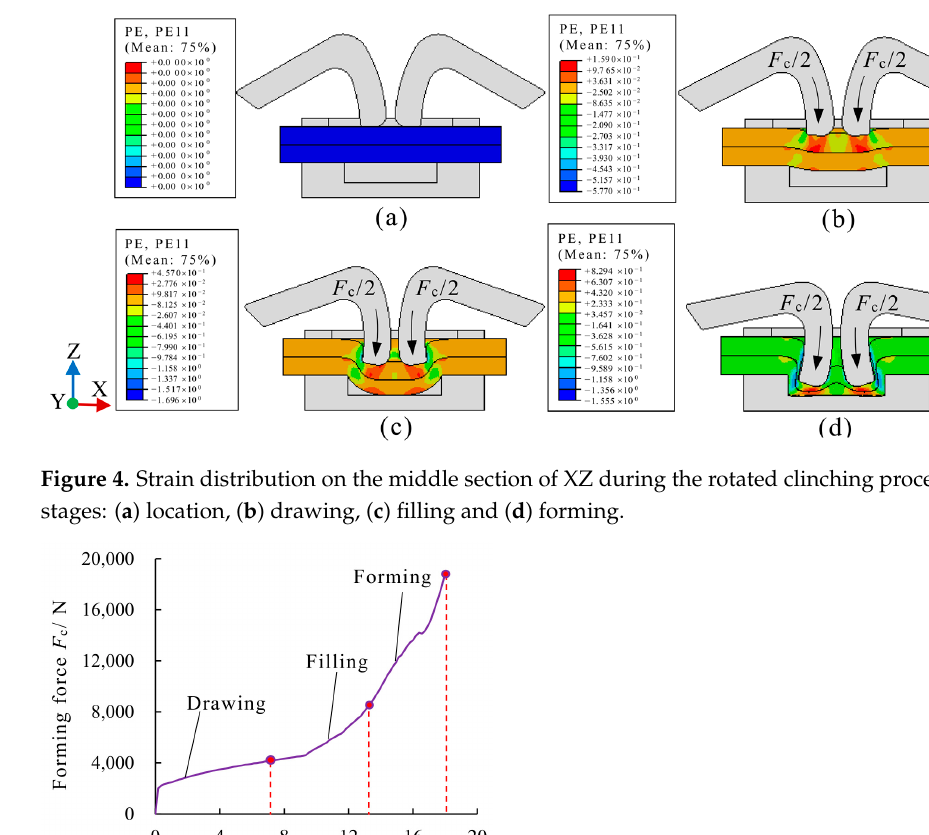
Figure 3. Stress distribution on the middle section of XZ during the rotated clinching process of four stages: ( a ) location, ( b ) drawing, ( c ) filling and ( d ) forming.